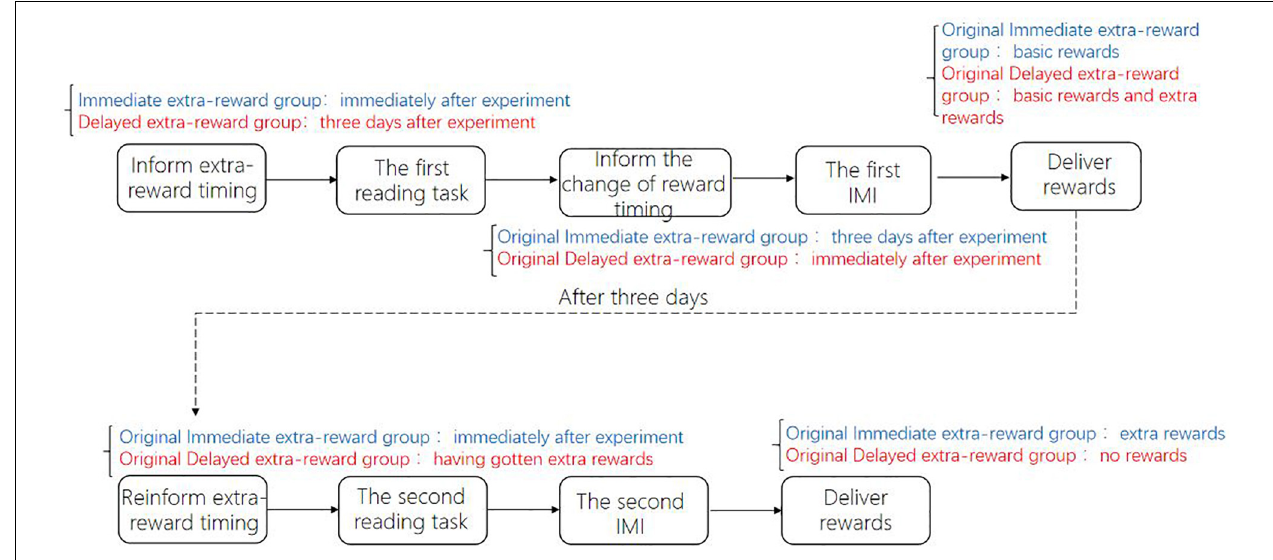
FIGURE 5 | Experimental procedure of Study